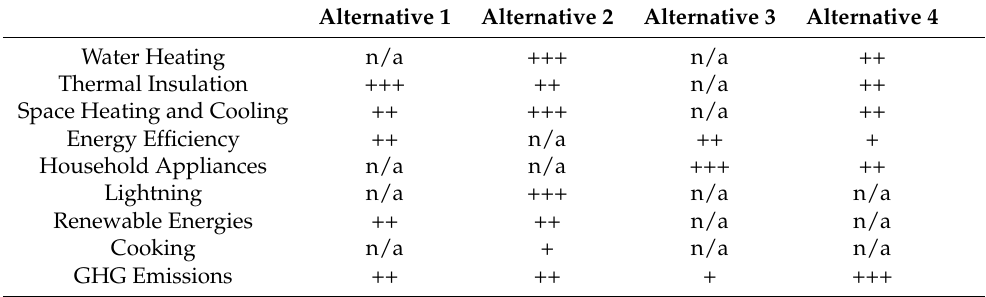
Table 1. Analysis and comparison of the measures applied in the different types of use for each